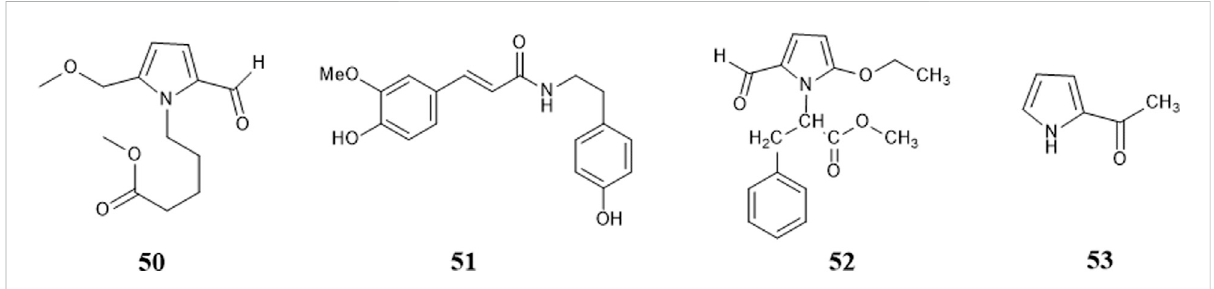
FIGURE 6 Structure of alkaloids from Bolbostemma paniculatum (Maxim.)